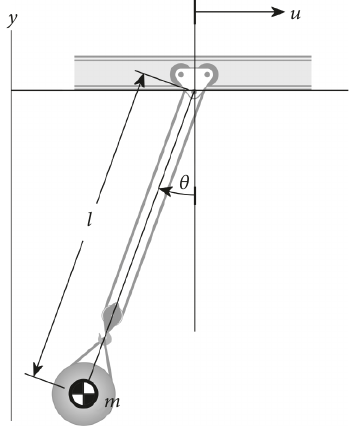
Figure 1: Overhead crane